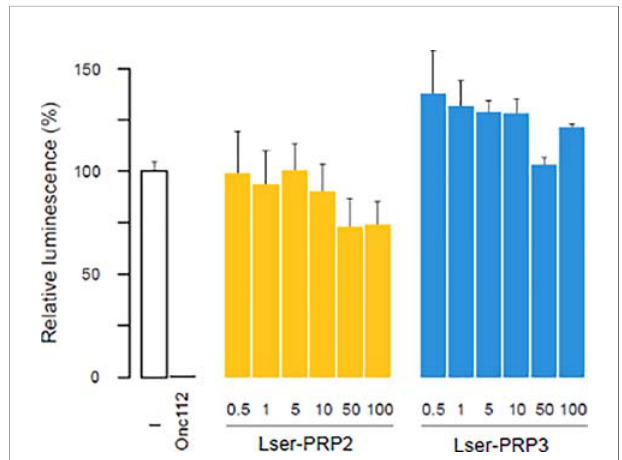
FIGURE 1 | Effect of Lucilia sericata proline rich peptides (PRPs) on bacterial protein synthesis. The graph shows the effects of increasing concentrations of Lser-PRP2 (yellow) and Lser-PRP3 (blue) on the luminescence produced following the translation of fi re fl y luciferase in an Escherichia coli cell free expression system. Data are means ± standard deviations (n=3) and the luminescence was normalized relative to that measured in the absence of peptide, which was set to 100%. The negative sample (white) indicates a control translation reaction performed in the absence of additional peptide. The concentration of peptide used in the Onc112 control was 10